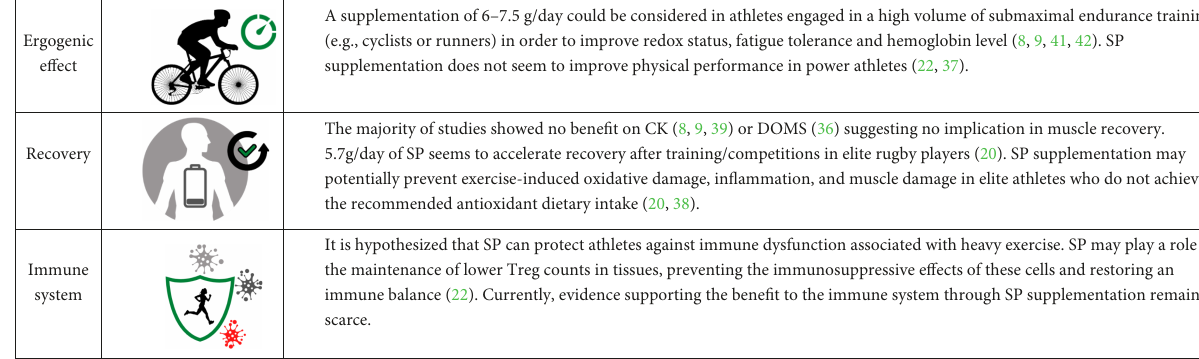
TABLE 2 Summary of research findings on the use of Spirulina in